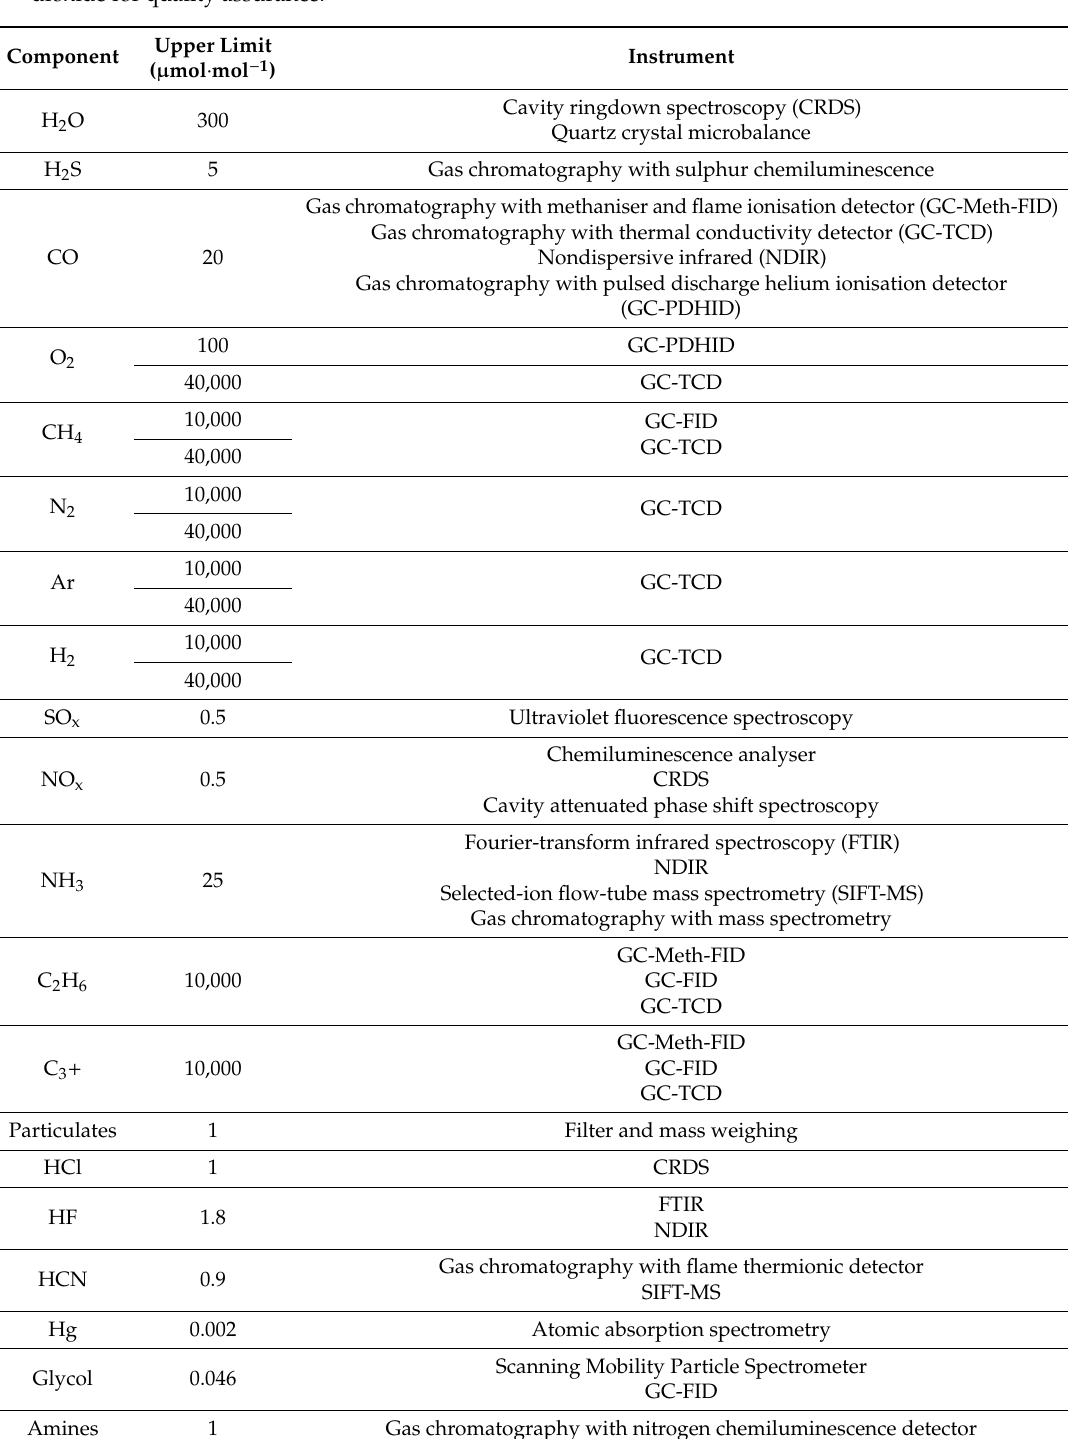
Table 6. Selection of analytical instruments for performing measurements of impurities in carbon dioxide for quality